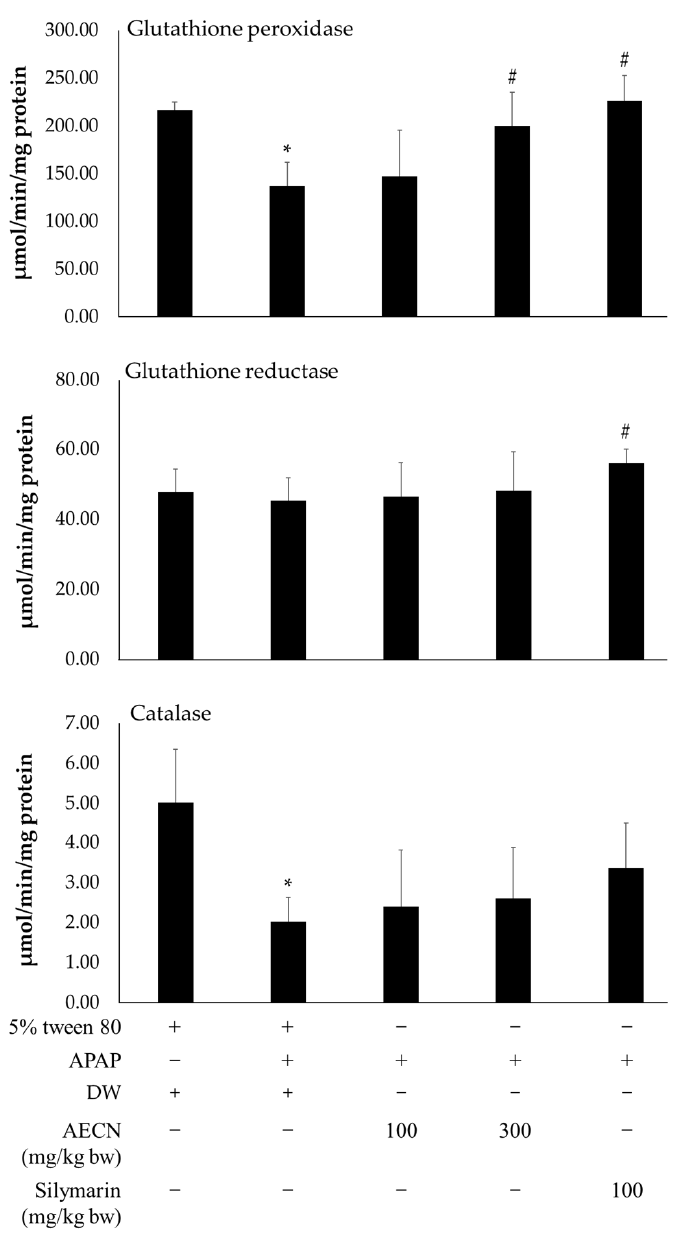
Figure 4. Effect of AECN on hepatic antioxidant system in APAP-treated rats. Data are expressed as mean ± SD values ( n = 8). * Significantly different from the control group ( p < 0.05), # Significantly different from the APAP-treated group ( p < 0.05). AECN: acidified ethanolic extract of C. nervosum pulp; APAP: acetaminophen at a dose of 3000 mg/kg bw; DW: distilled water used as a vehicle for AECN; 5% tween 80 used as a solvent control for APAP.